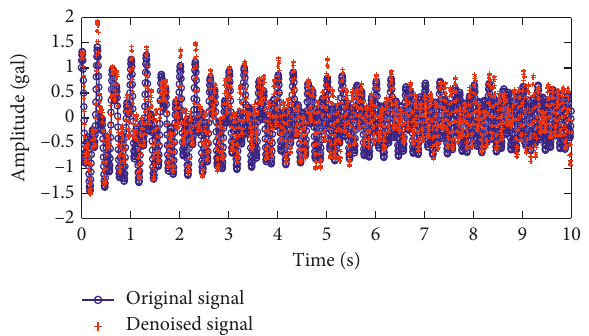
Figure 7: Comparison figure of original signal and denoised signal using EEMD-Wavelet-SSA.